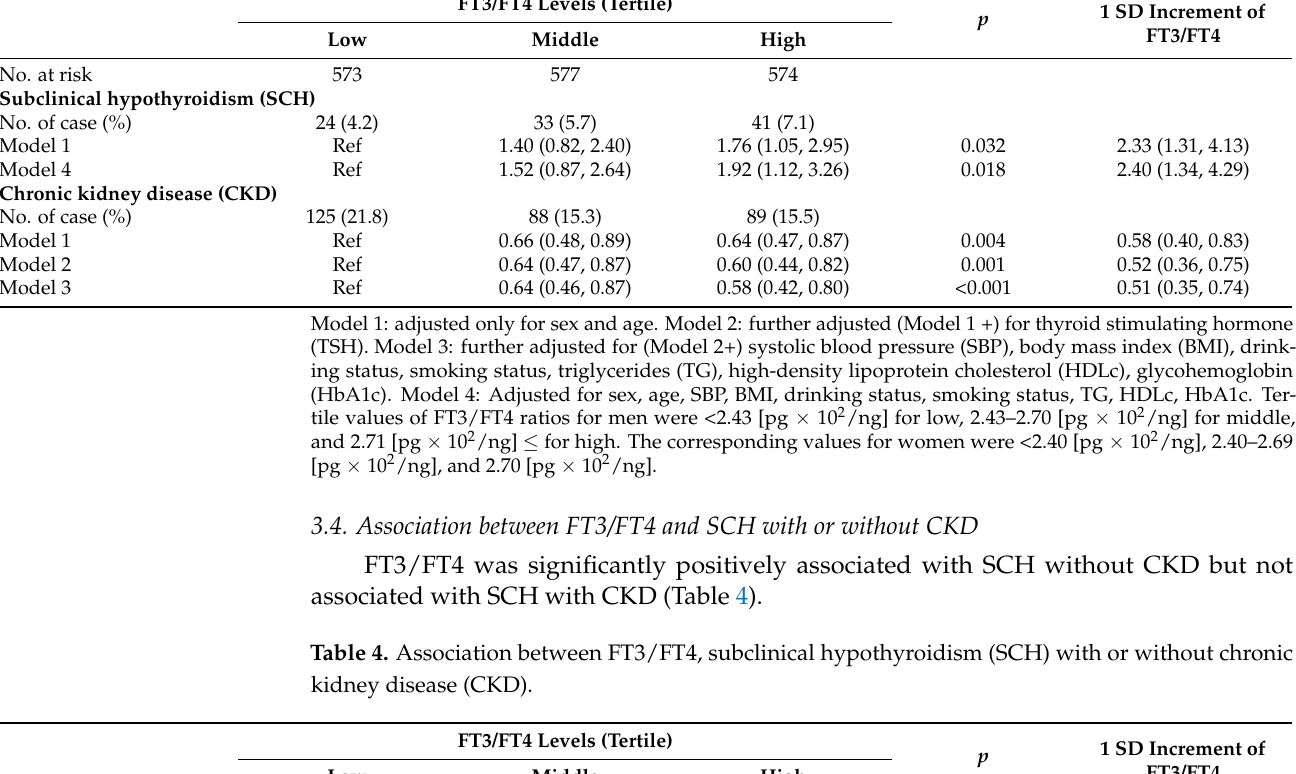
p 1 SD Increment of FT3/FT4 Low Middle High